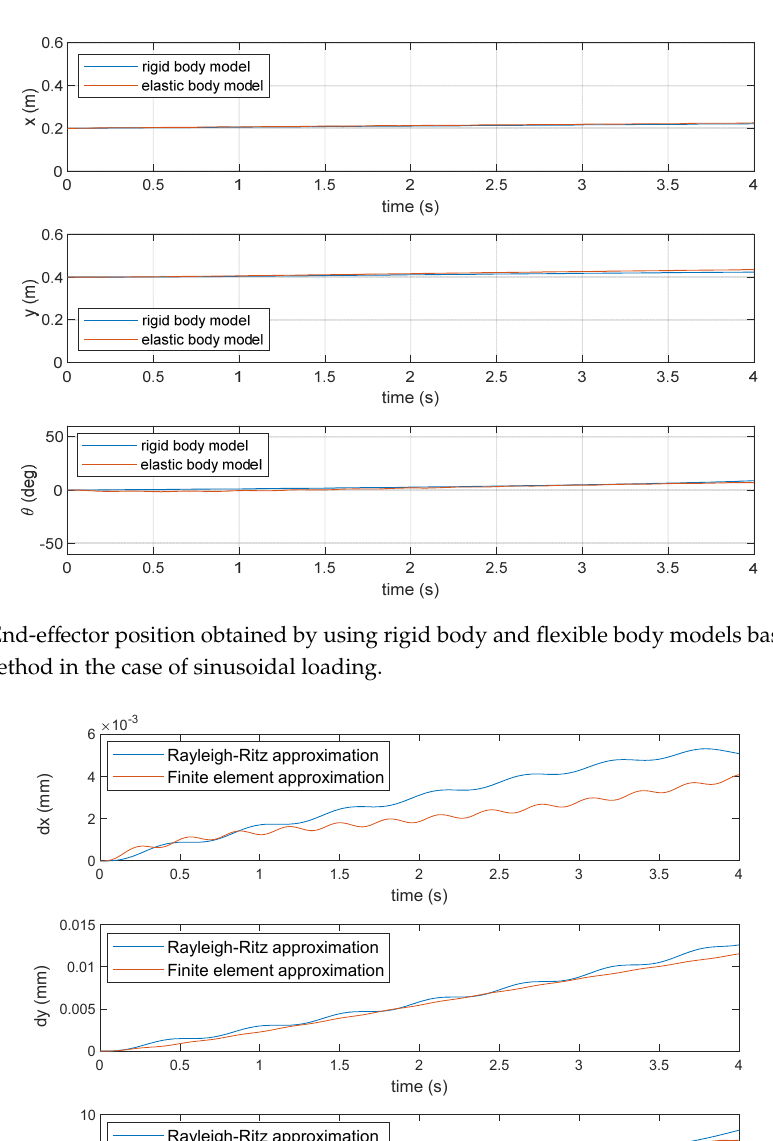
Figure 9. End-effector position obtained by using rigid body and flexible body models based on finite element method in the case of sinusoidal loading.